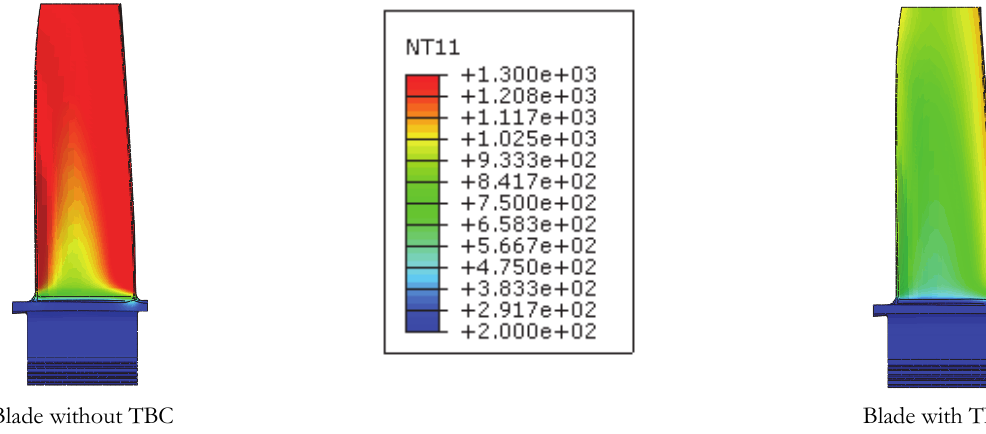
Figure 9: Distributions of the temperature in the turbine